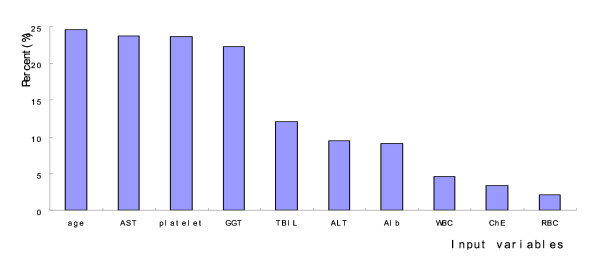
Sensitivity analysis of input variables. The horizontal axis is the input variables; the vertical axis is the percent change on the output variable. The value shown for each input variable is a measure of its relative importance, with 0 representing a variable that has no effect on the prediction and 1 representing a variable that completely dominates the prediction.